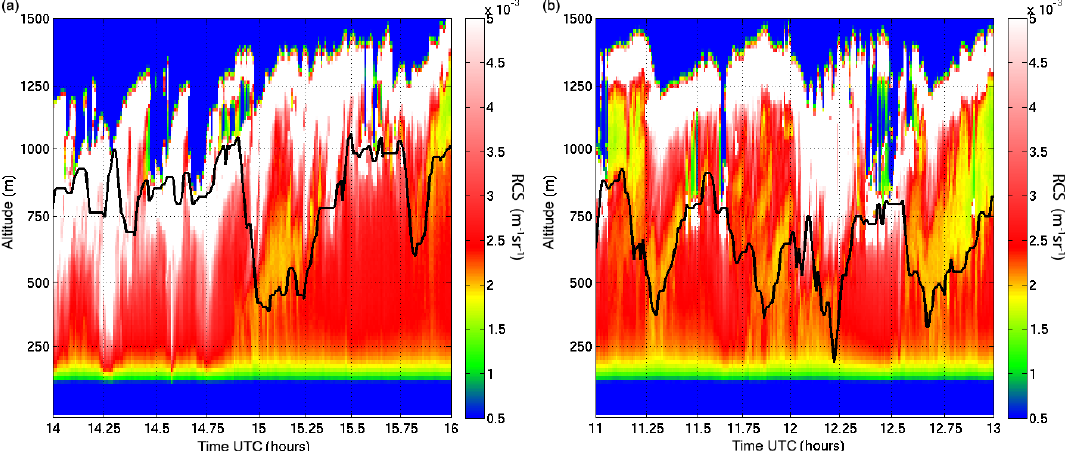
Figure 9. Highlights of the MLH estimate found by the pathfinder algorithm on 20 June 2010. See text in Sect. 4.2. Shown are (a) precipitation events reaching the lidar overlap region and (b) precipitation evaporating well above this